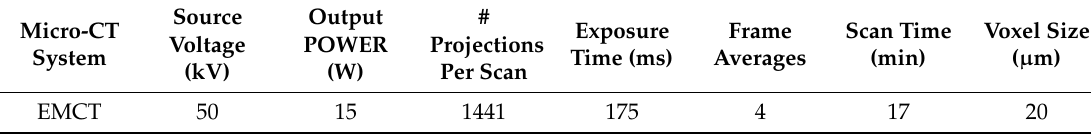
Table 1. Scanning parameters of the experiments.